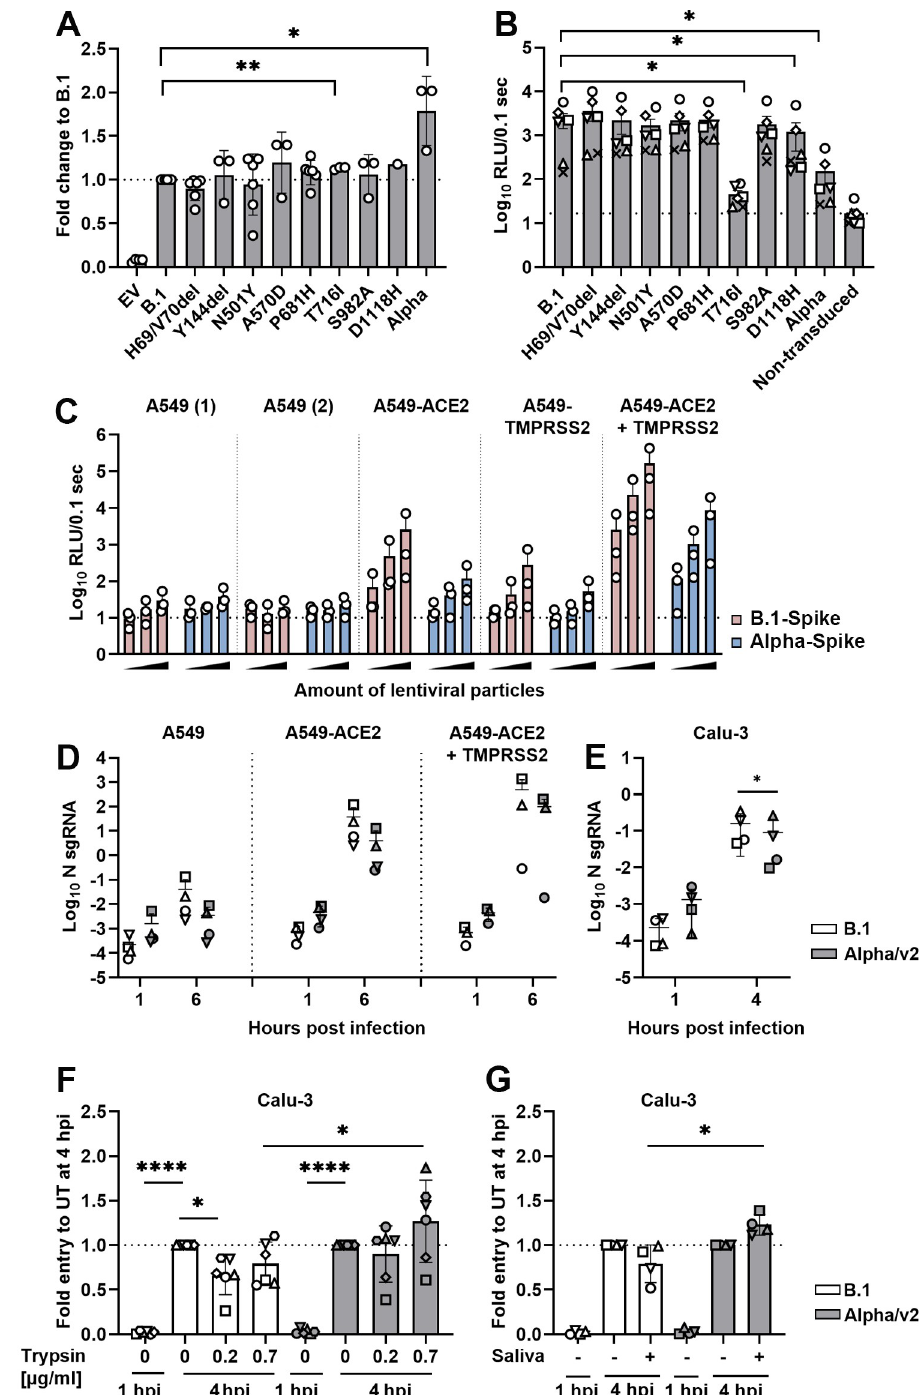
Fig 6. Enhanced cell–cell fusion and reduced virus particle entry by VOC Alpha SARS-CoV-2 spike. ( A ) For Tat- mediated cell–cell fusion assay, CHO cells were cotransfected with plasmids expressing indicated spike-HA and HIV-1 Tat. LTR-luciferase-expressing target TZM-bl cells were transfected with plasmids encoding human ACE2 and TMPRSS2. Transfected cells were cocultured for 8 hours and luciferase expression resulting from intercellular Tat transfer was quantified luminometrically. All values were normalized to B.1 spike (indicated by a dotted line). Shown are results from 3–6 biological replicates, each performed in triplicates. ( B ) Calu-3 cells were transduced with lentiviral pseudoparticles expressing luciferase and decorated with indicated spike-HA. Transduction efficiency was